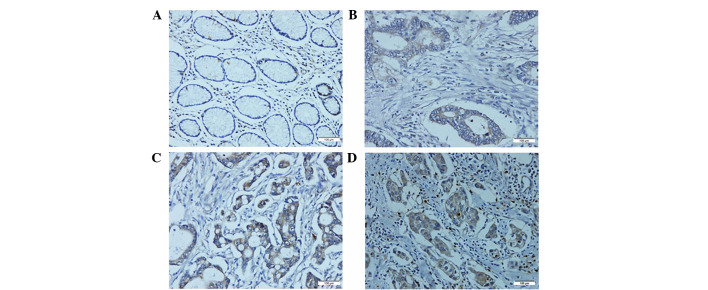
Astrocyte elevated gene-1 (AEG-1) protein expression in gastric cancer (GC) surgical specimens shown by immunohistochemistry. Immunohistochemical staining for AEG-1 was predominantly observed in the cytoplasm of the GC cells. Weak AEG-1 staining was observed in (A) the non-cancerous gastric mucosa and (B) the well-differentiated GC cells. Strong AEG-1 staining was observed in the (C) moderately and (D) poorly differentiated GC cells (stain, 3,3′-diaminobenzidine; scale bar, 100 μm; magnification, ×200).